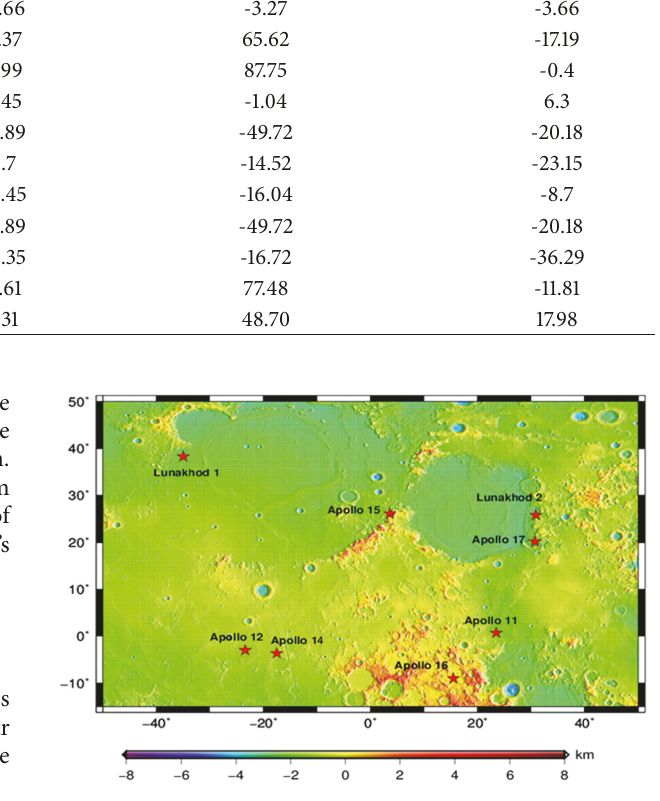
Figure 5: Distribution of LLRR and ALSEP on the lunar